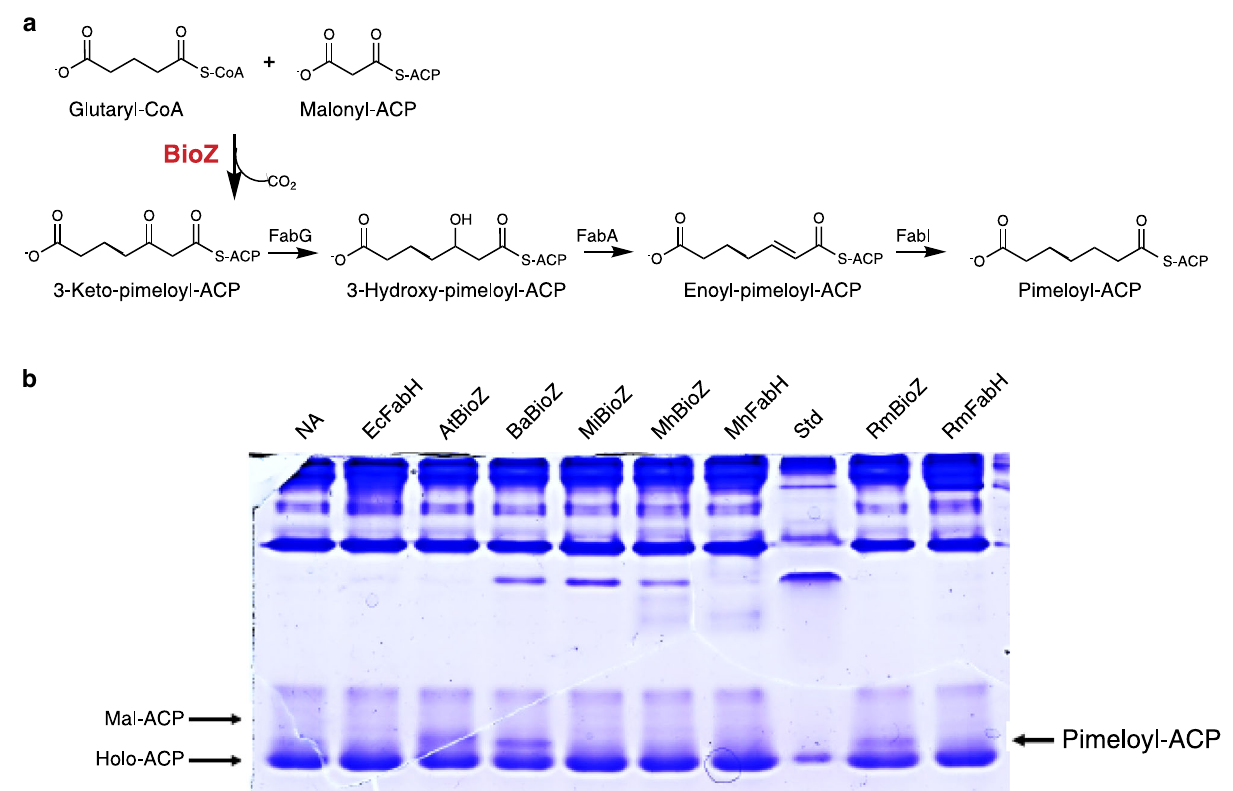
Fig. 5 Condensation activity of BioZ. a Scheme for testing elongation of glutaryl-CoA with malonyl-ACP. The unstable product of decarboxylative condensation was converted to pimeloyl-ACP by successive reduction, dehydration, and reduction steps catalyzed by the E. coli fatty-acid synthetic (Fab) enzymes as shown. BioZ is in red font. b Conformationally sensitive urea electrophoretic separation of ACP species. The At, Ba, and Rm BioZ proteins catalyze formation of a product having the mobility of pimeloyl-ACP whereas three different FabH proteins and the Mj and Mh BioZs failed to form the product. This gel and gels in which alternate primers and elongation substrates were tested are given together in Supplementary Figure 3. Each experiment was repeated more than three times and the gel given is representative. Strain abbreviations are given as in Fig.